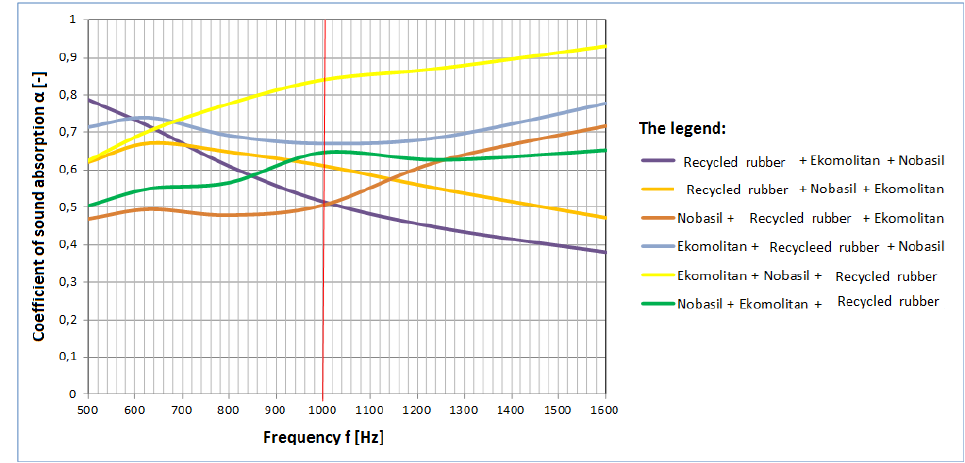
Figure 12. Sound absorption coefficient of three-layered sandwiches (total thickness of sandwiches—60 mm).